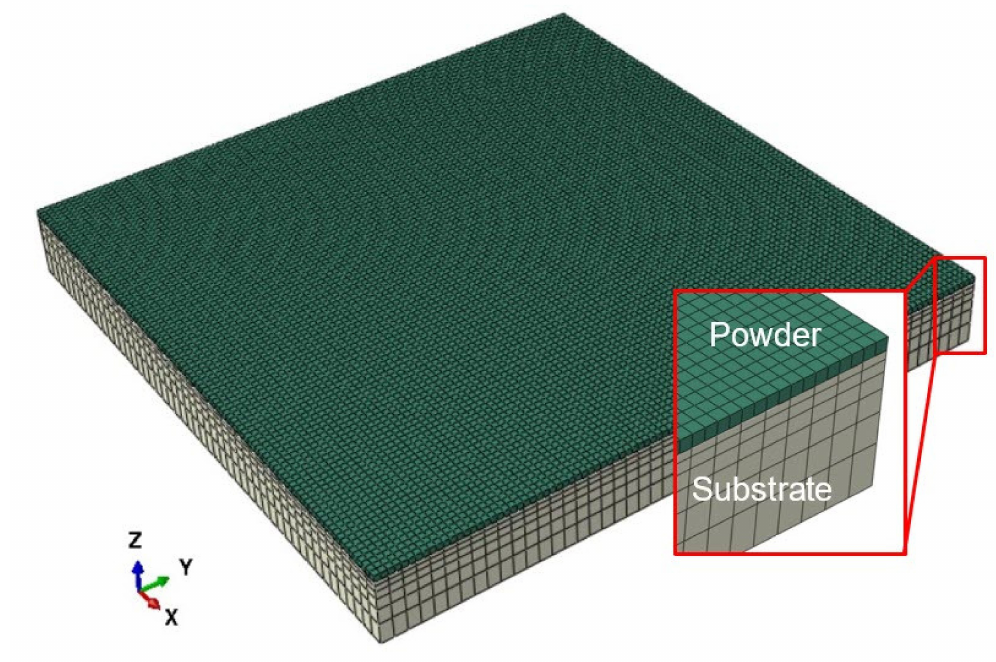
Figure 3. Multi-track